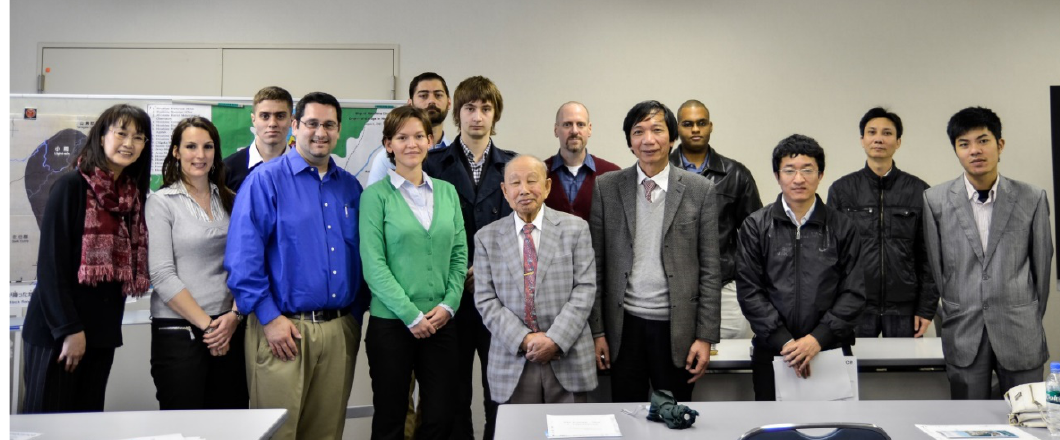
Figure 5. Students and faculty from Texas A&M, the Tomsk Polytechnic University of Russia, and the Hanoi University of Science of the Vietnamese National University visiting a Hiroshima survivor Keijiro Matsushima during the NFE to Japan in